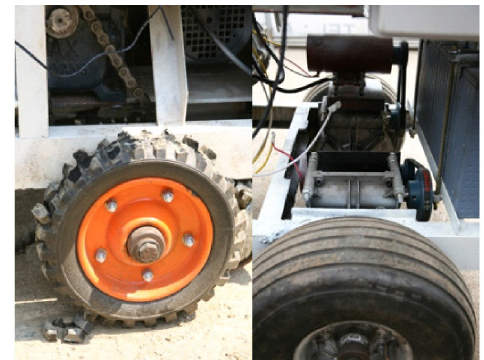
Fig. 4. Prototype tire